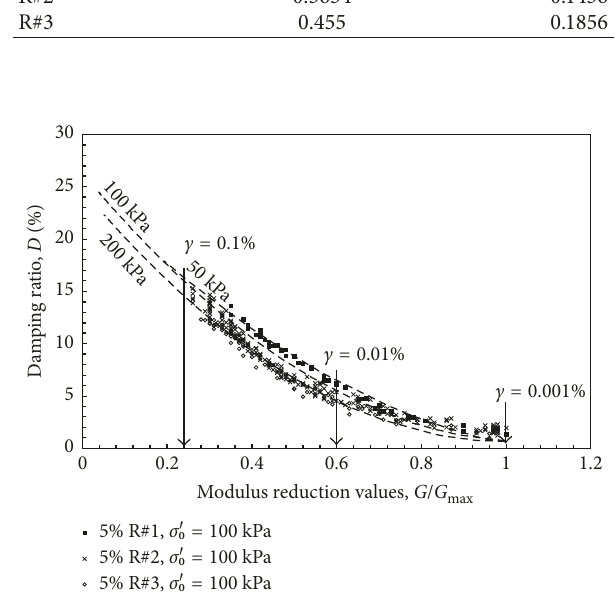
Figure 10: Relationship between shear modulus and damping ratio for 5% rubber content.